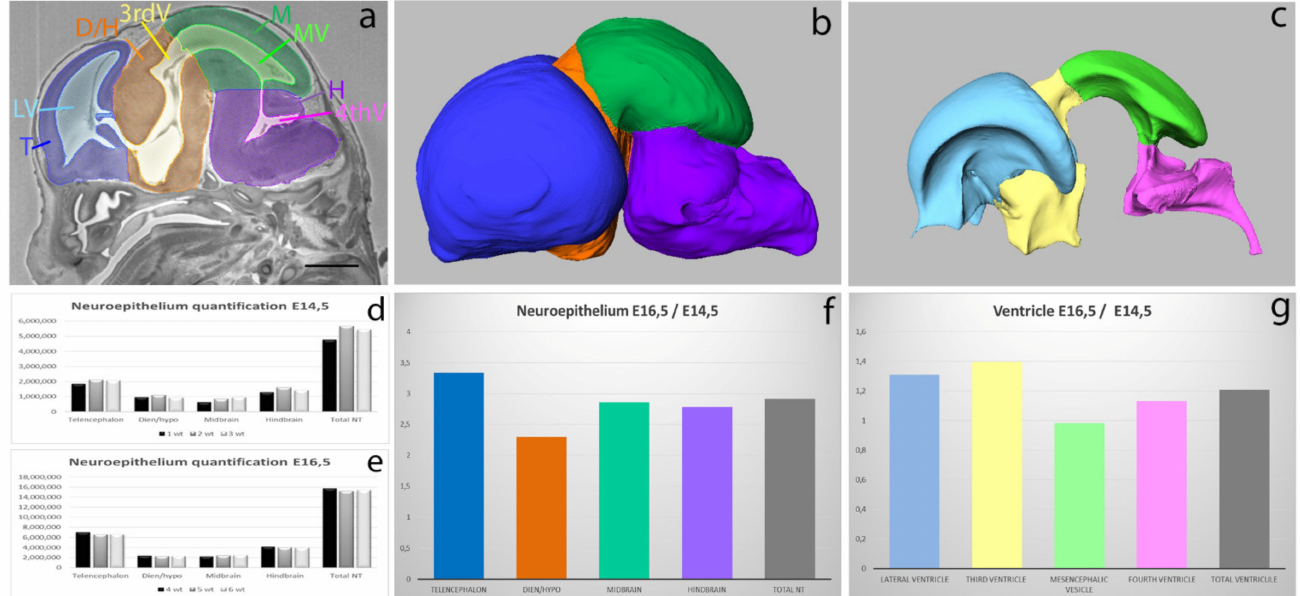
Figure 2. Quantification of neuroepithelium tissue and ventricular system in E14.5 and E16.5 mouse fetuses. Manual segmentation of different structures of the neuroepithelium and ventricles on HREM 2D raw data ( a ). 3D reconstructions of the neuroepithelium ( b ) and ventricles ( c ) at stage E14.5. Quantification of neuroepithelium tissue at E14.5 ( d ) and E16.5 ( e ). The x -axis represents the structures in the 3 animals and the y -axis represents the voxel size (represented in pixel numbers). Representation of the ratios E16.5/E14.5 in the neuroepithelium ( f ) and ventricle ( g ) volumes. The x -axis represents the structures and the y -axis represents the volume ratios. T: telencephalon, D/H: diencephalon and hypothalamus, M: midbrain, H: hindbrain, LV: lateral ventricles, 3rd V: Third ventricle, MV: mesencephalic ventricle, 4th V: fourth ventricle. Scale bar: 1